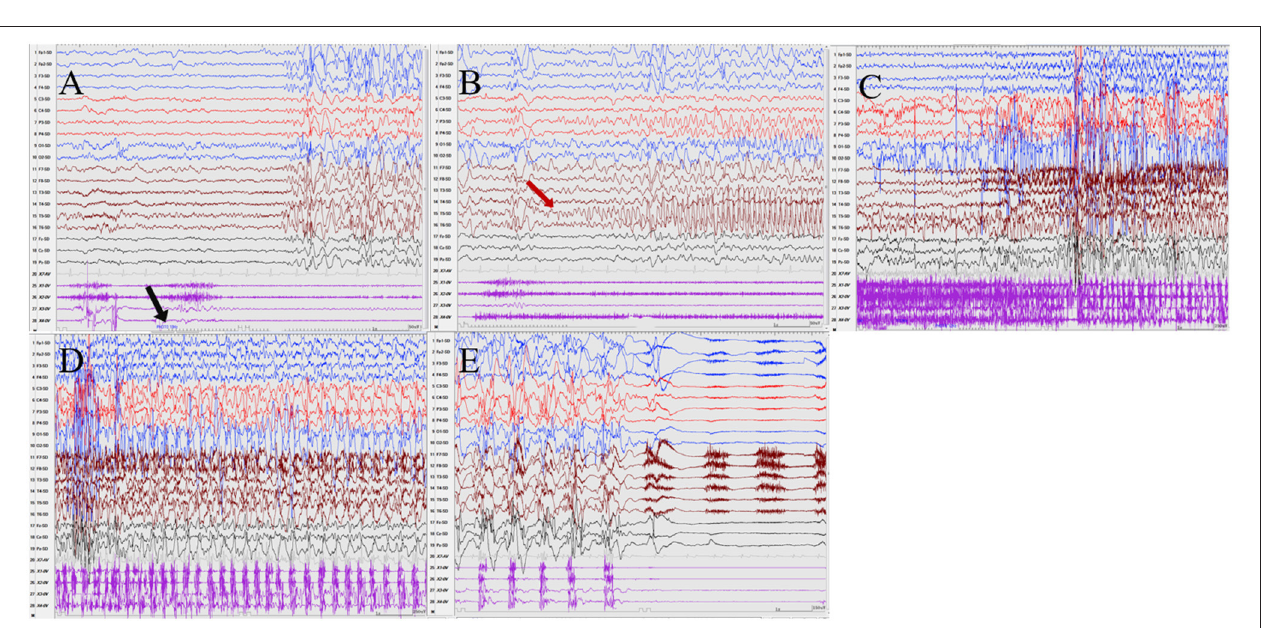
FIGURE 3 | The ictal EEG of patient 2 (A – E) 3–3.5Hz generalized spike and waves → left posterior temporal spikes rhythm (T5) → spread to the occipital and left parietal regions (O1, P3) → generalized fast wave rhythm → slow wave insertion. (The red arrow represents the origin of the seizure; the black arrow represents the starting point of the IPS.) (EEG, electrocardiogram; IPS, intermittent photic stimulation; X1, left deltoid; X2, right deltoid; X3, left quadriceps; X4, right